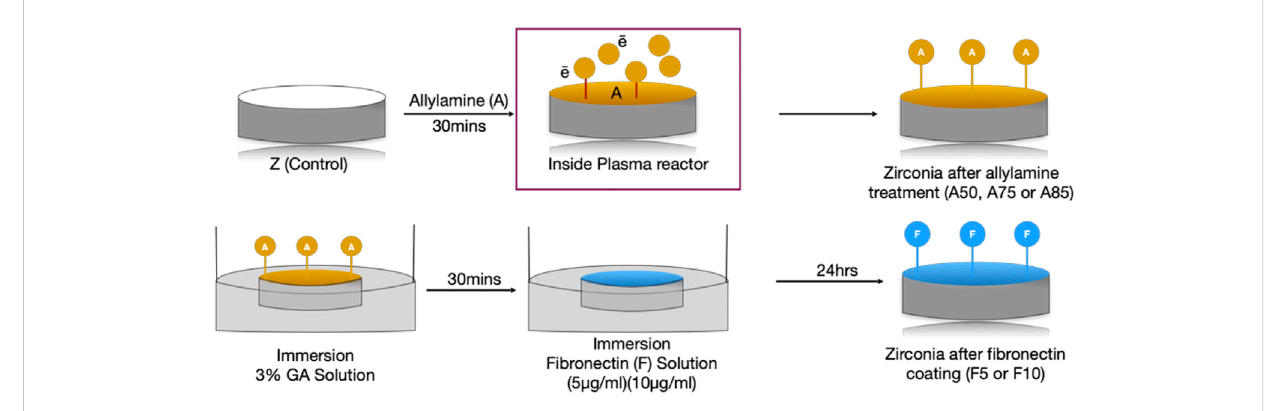
FIGURE 2 Illustration of fl owchart of sample preparation and protein